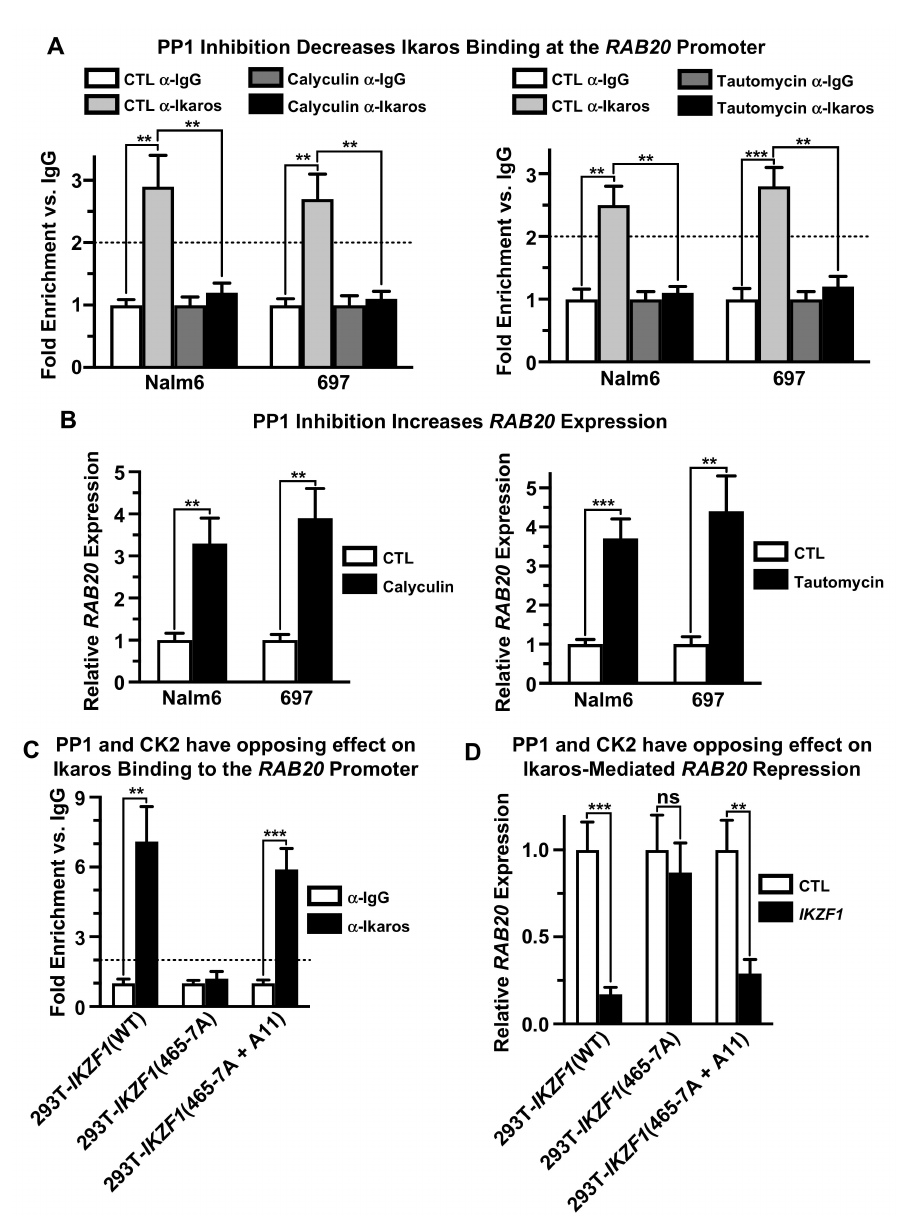
Figure 5. PP1 regulates repression of RAB20 by Ikaros. ( A ) Human B-ALL cell lines were treated with pharmacological PP1 inhibitors calyculin and tautomycin. qChIP was used to determine Ikaros occupancy at the RAB20 promoter. ( B ) RAB20 expression was analyzed using qRT-PCR after PP1 inhibition with calyculin and tautomycin. ( C ) HEK293T cells were transduced with wild-type Ikaros ( IKZF1 (WT)), Ikaros with the mutated PP1 binding-site ( IKZF1 (565-7A)), and Ikaros with the PP1 binding-site mutated and phosphoresistant alanine mutations at CK2 phosphosites ( IKZF1 (465-7A + A11)). qChIP was used to determine Ikaros binding at the RAB20 promoter. ( D ) qRT-PCR was used to determine RAB20 expression in HEK293T cells transduced with wild-type Ikaros ( IKZF1 -(WT)) and mutated Ikaros ( IKZF1 -(465-7A) and IKZF1 -(465-7A + A11)). The graphed data are the mean ± SD (error bars) from three independent